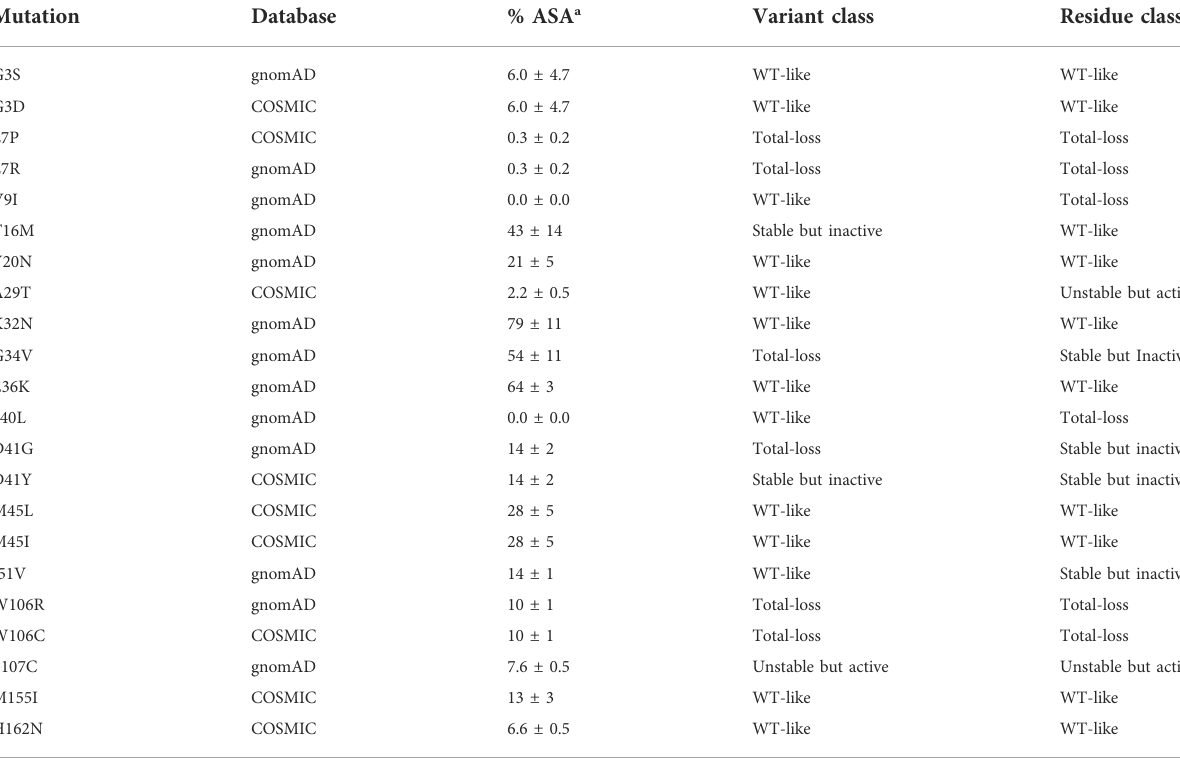
The table indicates whether the variants are found in the COSMIC/gnomAD databases as well as the solvent exposure (as % ASA) determined using a crystallographic model of WT NQO1 [PDB code2F1O (Asher et al., 2006)], the softwareGetarea and thecomputational classi fi cationat variantand residue level using a combinationof predictions of